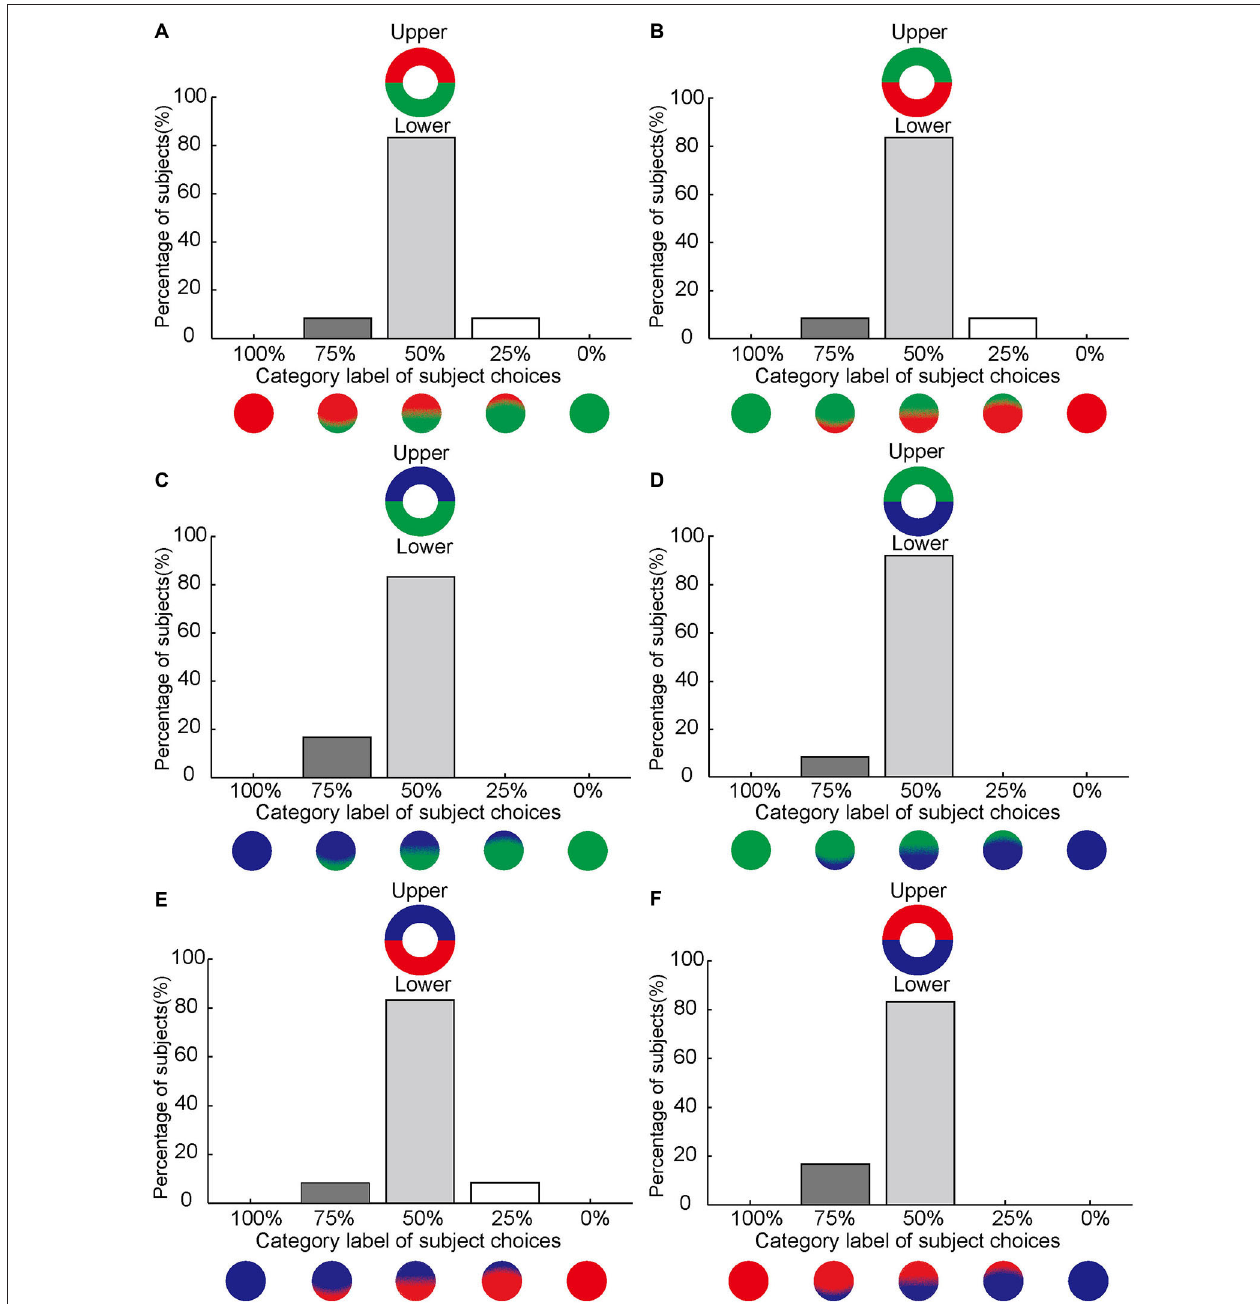
FIGURE 4 | No asymmetrical effect of color filling-in between upper and lower sides of the blind spot. (A–F) Same format as Figure 3 but for stimuli subdivided into upper and lower halves.